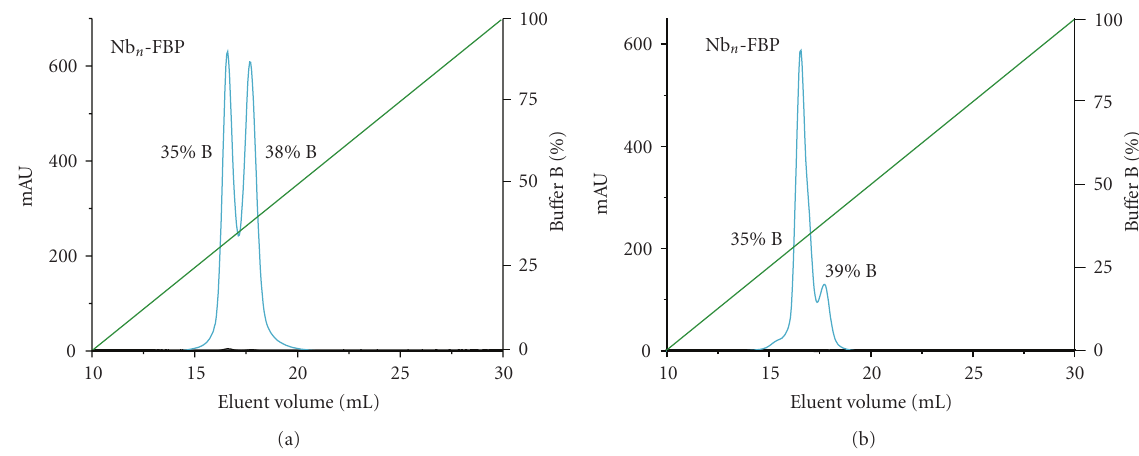
Figure 6: Characterization of Nb n -FBP (apo-Fbp reloaded with [Cp 2 Nb(OH)Cl 2 ] (a) or [Nb(NTA) 2 ] (b)) by chromatography on a MonoS HR 5/5 column. The left axis shows the absorption profile at 280 nm, and the right axis is the percentage of bu ff er B (10 mM Hepes, 1M NaCl, pH7.5). Green line: gradient of the bu ff er B applied during the elution process; cyan line: absorbance at 280nm.